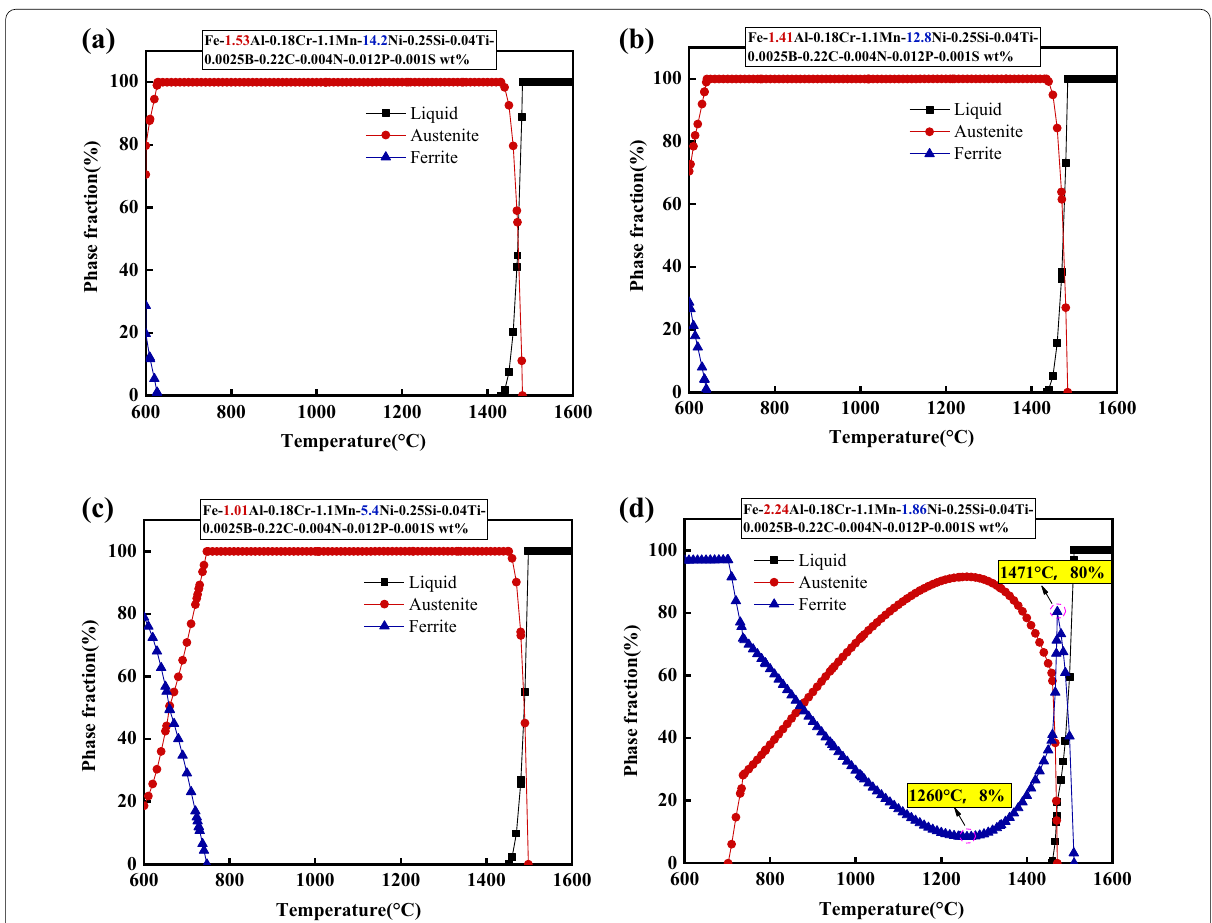
Figure 13 Simulated phase transformation by JMatPro with different oscillation amplitude: a A soc A soc in = 1.3